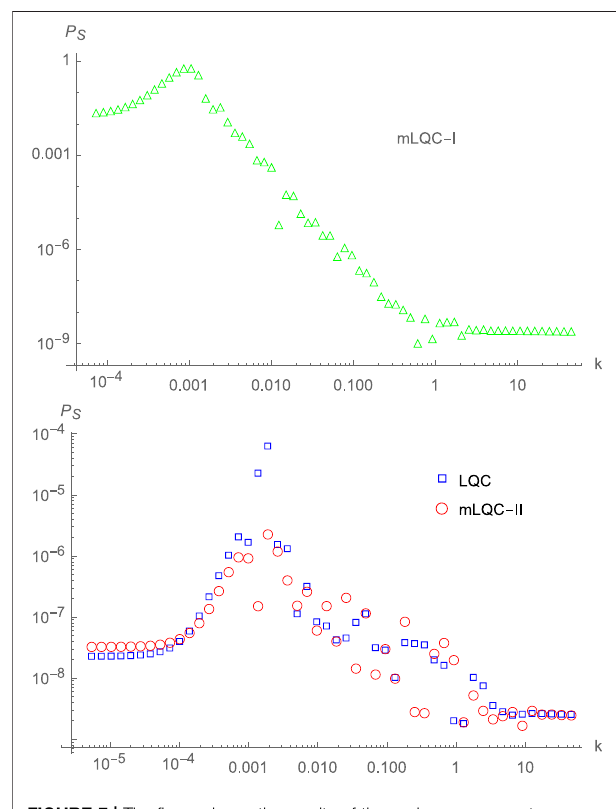
FIGURE 7 | The fi gure shows the results of the scalar power spectra from three models presented in (Li et al., 2020c) when the potential term is given by Ω 2 eff . The in fl ationary potential is chosen to be the quadratic potential and the e-foldings of the in fl ationary phases in all three models are chosentobe72.8.The fi rstpanelshowsthescalarpowerspectruminmLQC- I which is characterized by its unique infrared regime. In the second panel, we compare the scalar power spectra from LQC and